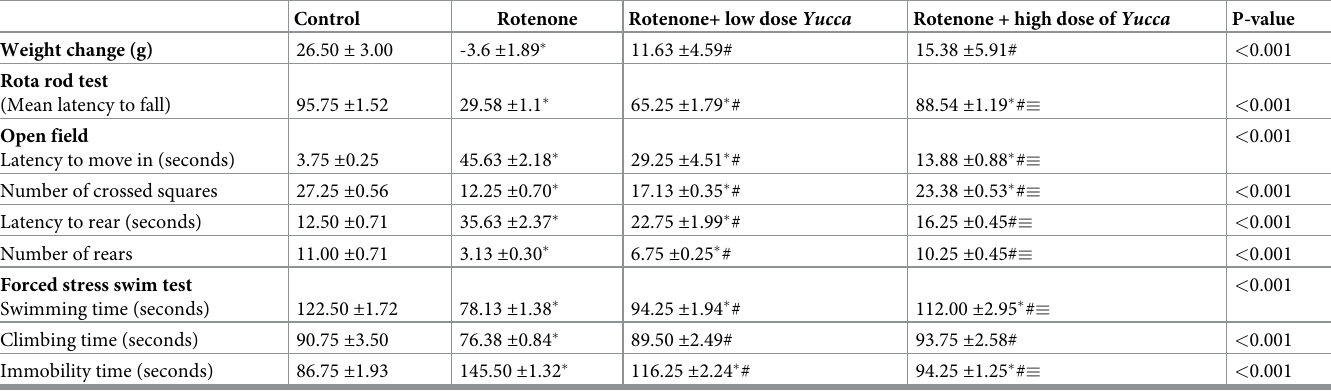
Table 3. Effects of rotenone and its co-treatment with Yucca extract on rats’ weight and